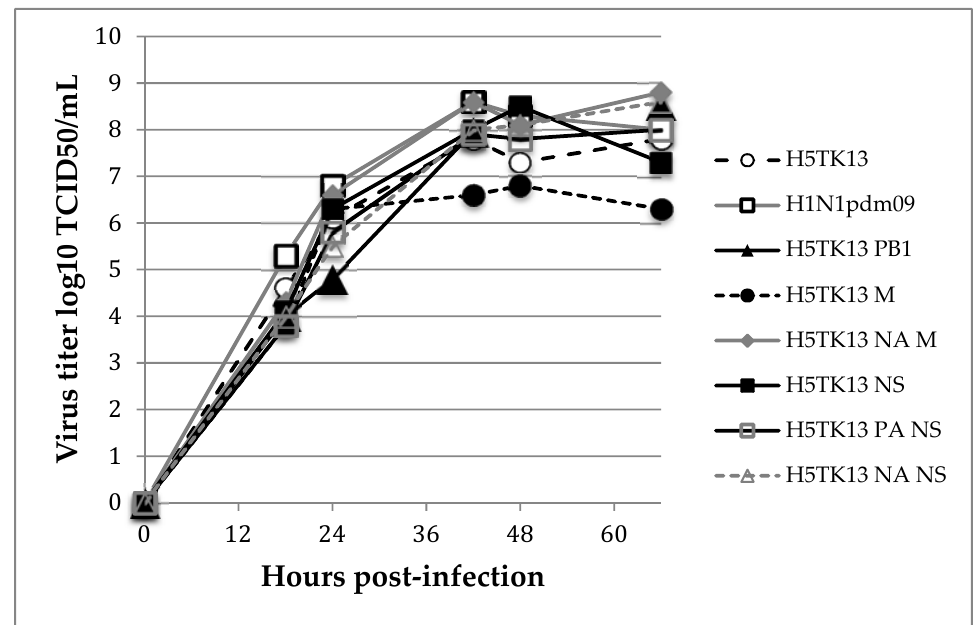
Figure 1. Replication of the wild-type and reassortant H5N1-H1N1pdm09 viruses in the MDCK cells.